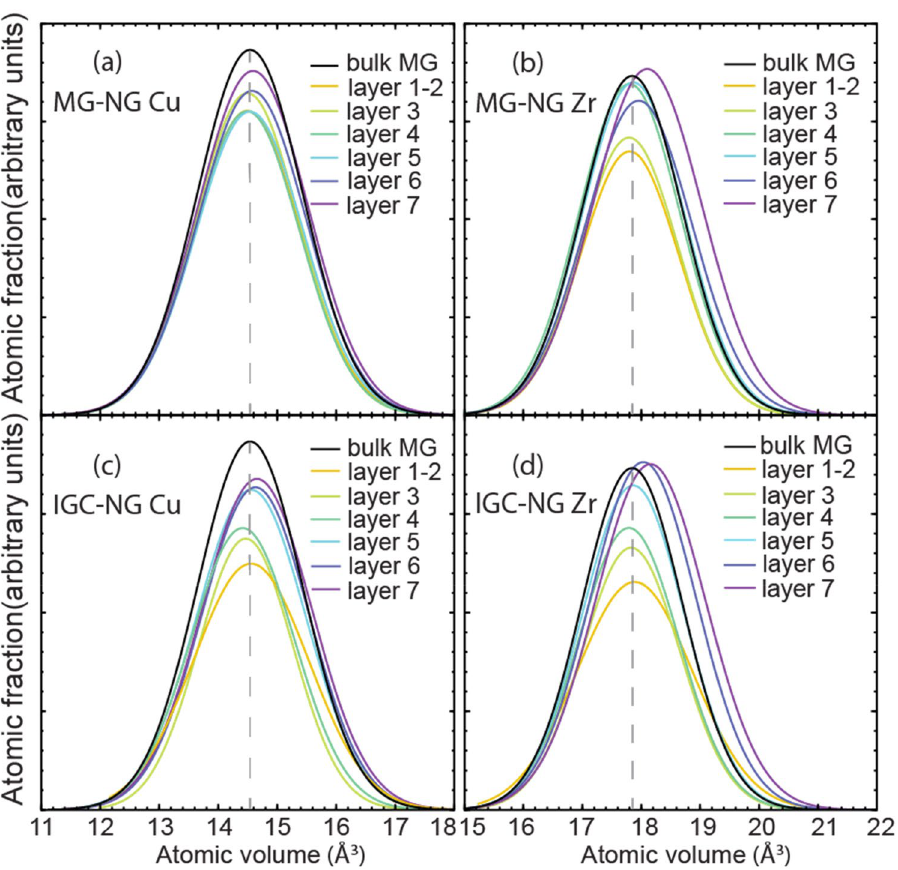
Figure 6. Voronoi atomic volume distribution in each layer of ( a )–( b ) IGC-NG and ( c )–( d ) MG-NG. The dash line indicates the peak position of the bulk MG curve. The atomic fraction is calculated by dividing the number of atoms of specific element in the selected layer. Each curve is fitted using a Gaussian distribution